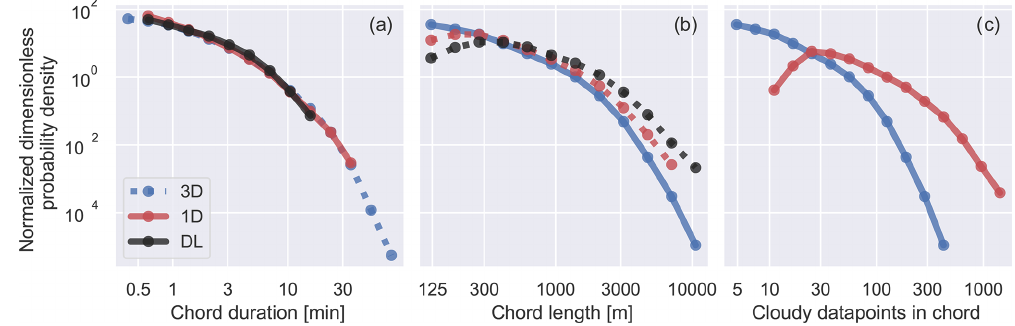
Figure 6. Distributions of (a) cloud chord duration, (b) chord length, and (c) number of cloudy data points per chord. Distributions of all chords listed in Table 2 are derived from the Doppler lidar (DL) observations, 3D model snapshots (3D), and 1D column output (1D) (description of chord detection in Sect. 3). Dashed lines indicate that the variable is derived from wind